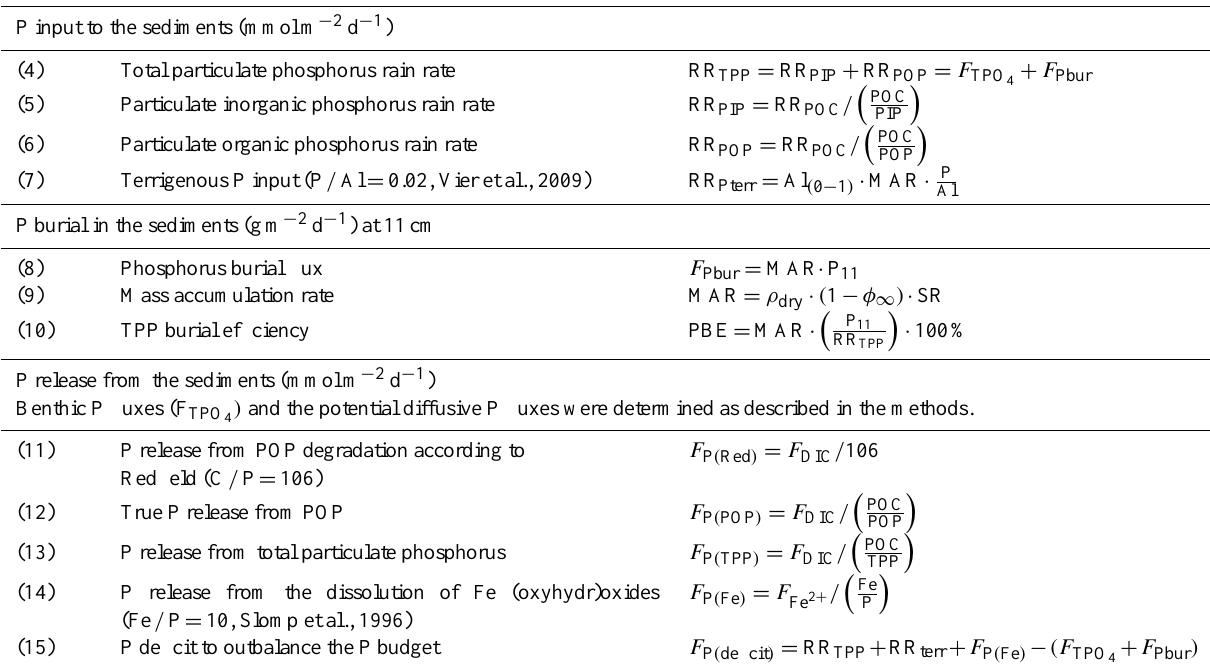
Table 2. Equations for the P mass balance calculations. Results are shown in Table